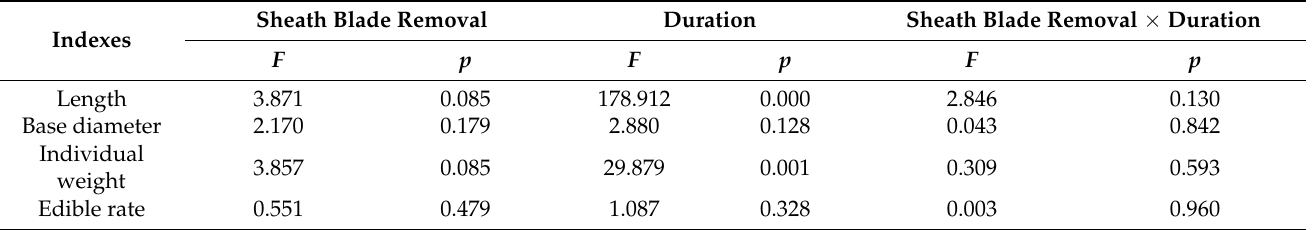
Table 1. Statistical two-way ANOVA results of sheath blade removal on morphological and edible rates of Ph. violascens